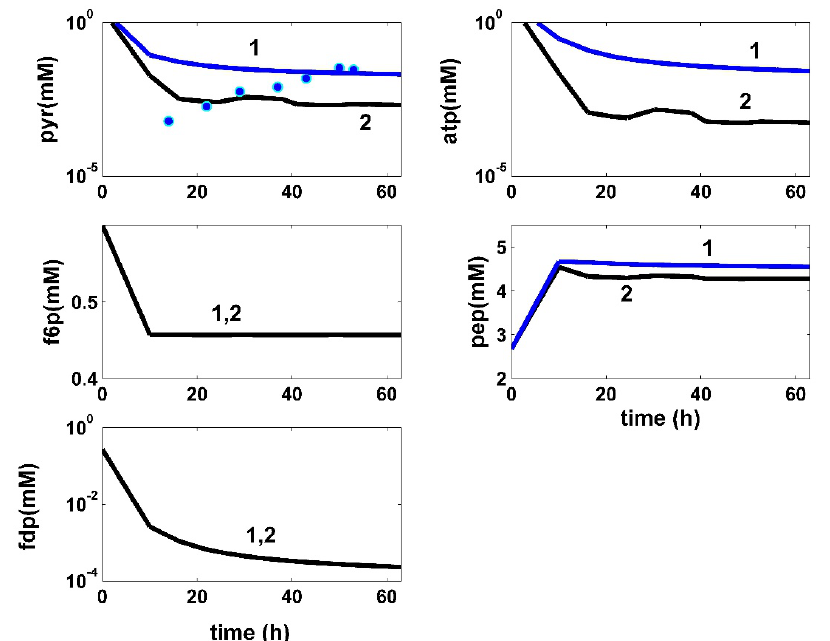
Figure 5. Model-based simulated trajectories (-) for the glycolytic key species (PYR, F6P, FDP, ATP, and PEP) in the modified E. coli T5 strain for the FBR operated in two alternatives: (i) (2, black) optimal operation derived in this paper (variable fed [GLC] and variable feed flow rate), and (ii) (1, blue) the experimental data ( • , blue) of Chen [71] recorded under nominal, nonoptimal operation of Table 1, with a constant fed [GLC] and a constant feed flow rate. Species abbreviations are given in the abbreviations